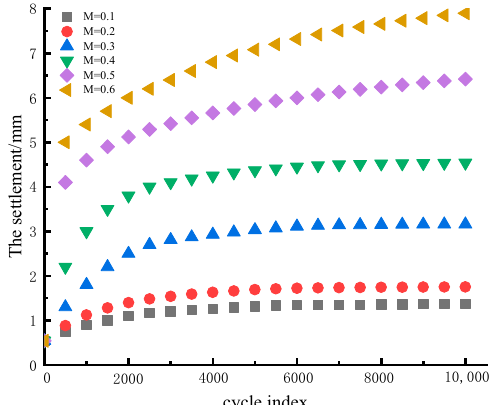
Figure 6. The CFMP fly ash composite foundation cyclic load settlement diagram.